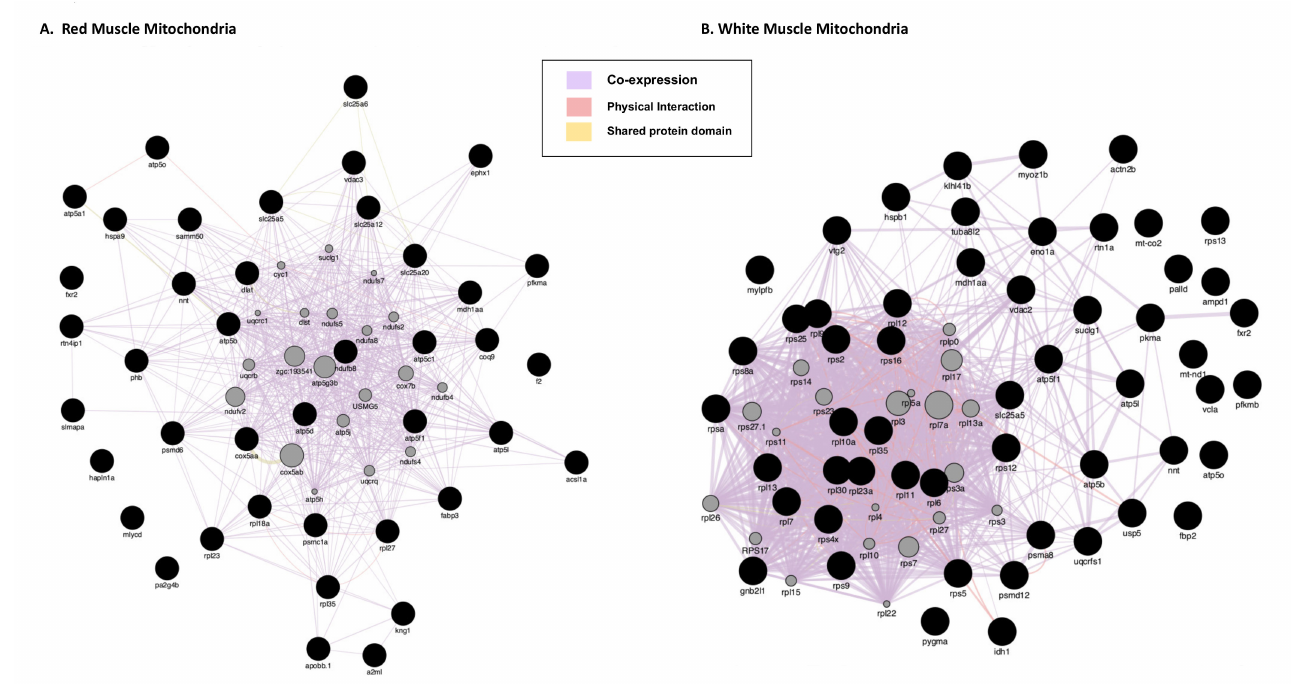
Figure 2. Gene interaction networks for DEPs with increased abudance in icefish. ( A ) RMM Analysis and ( B ) WMM Analysis. A GeneMANIA gene–gene interaction network for protein abundance following the pattern N. rossii (+/+), T. bernacchii (+/+), C. rastrospinosus ( − /+) and C. gunnari ( − / − ) in increasing order of their protein abundance, laid out and visualised with Cytoscape, showing interaction strength (edge thickness), interaction type (colour-bottom right), multiple edges between nodes, and protein score (node size). Black nodes indicate query proteins, and grey nodes are neighboring proteins with interactions as co-expressed, physical, or shared protein